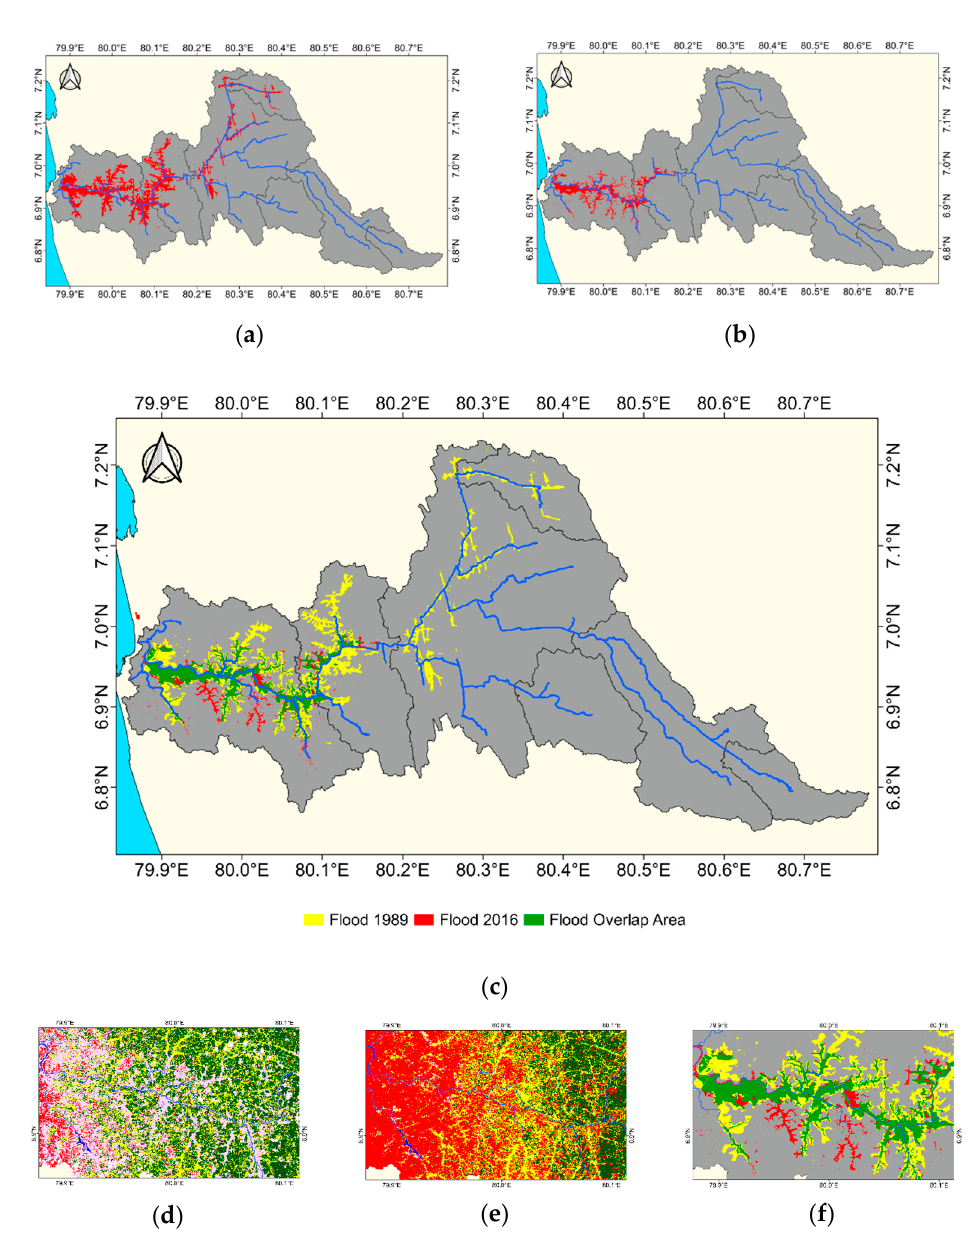
Figure 6. Historical flood inundations of Kelani River Basin: ( a ) For 1989 flood; ( b ) for 2016 flood; ( c ) comparison of inundated areas from two floods; ( d ) 1989 LULC; ( e ) 2016 LULC; ( f ) flooded area comparison.